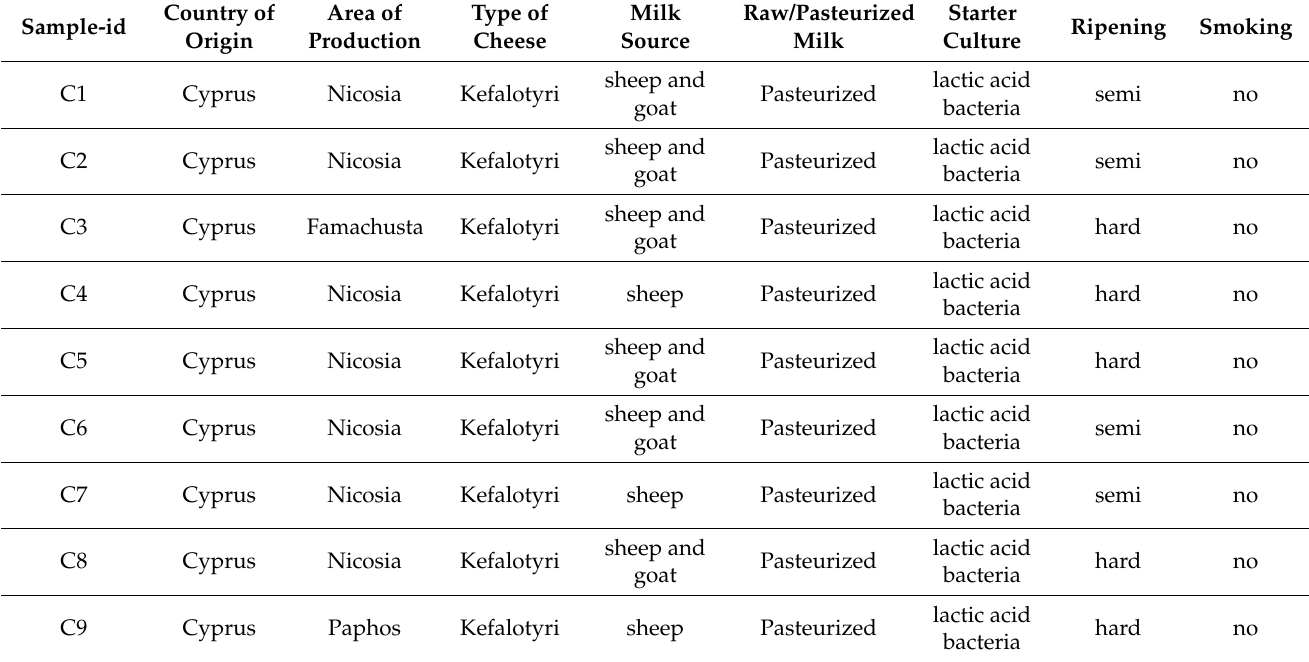
Figure 1. Map of cheese samples collection countries. Table 1. Information about the collected samples (cheeses have been anonymized for commercial reasons).